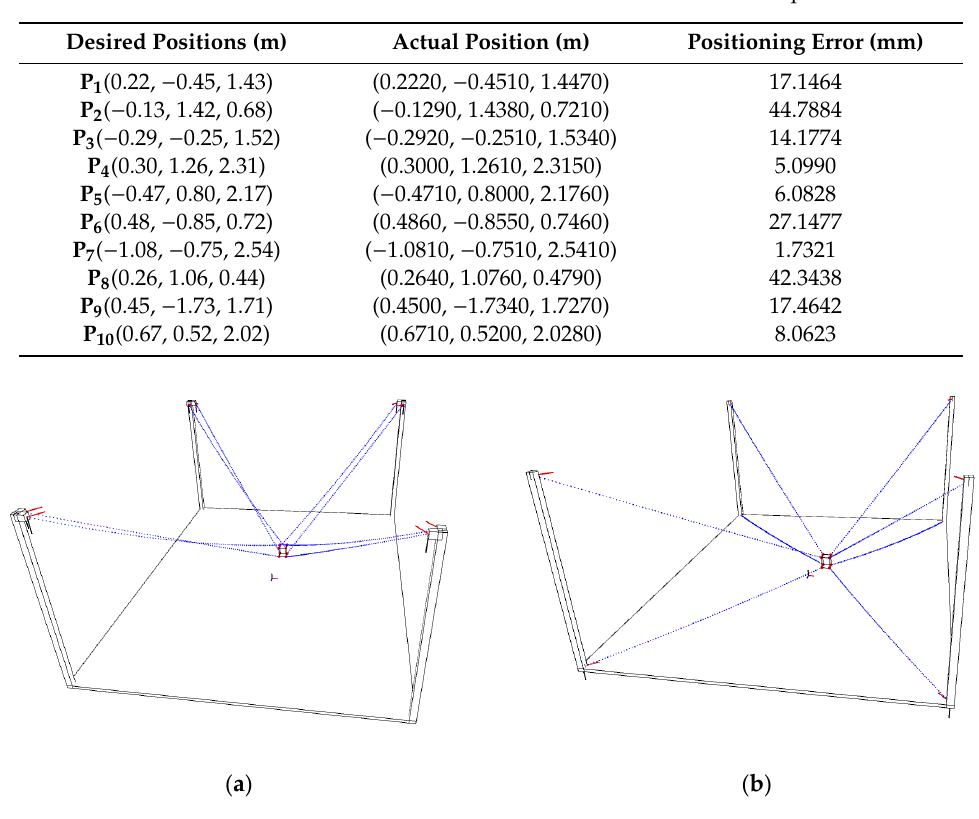
Figure 17. ( a ) The first configuration; ( b ) the second configuration used in simulation test.